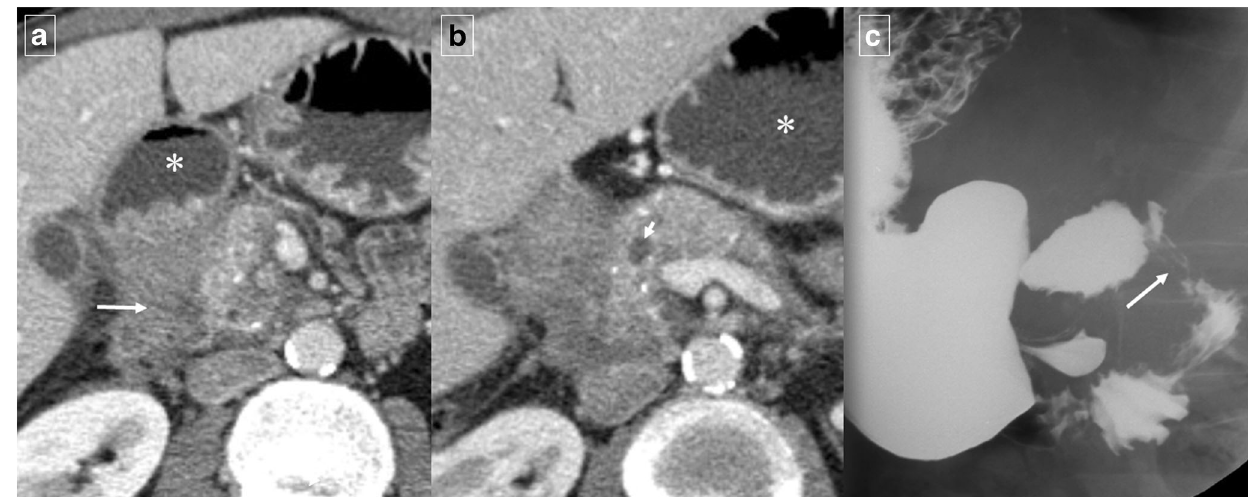
Fig. 16 A 55-year-old man with history of alcohol abuse and chronic pancreatitis. Axial contrast-enhanced CT images ( a and b ) demonstrate atrophy of the pancreatic parenchyma and ductal dilation (short arrow). A stricture of the duodenal lumen (arrow) caused by fibrotic changes in the